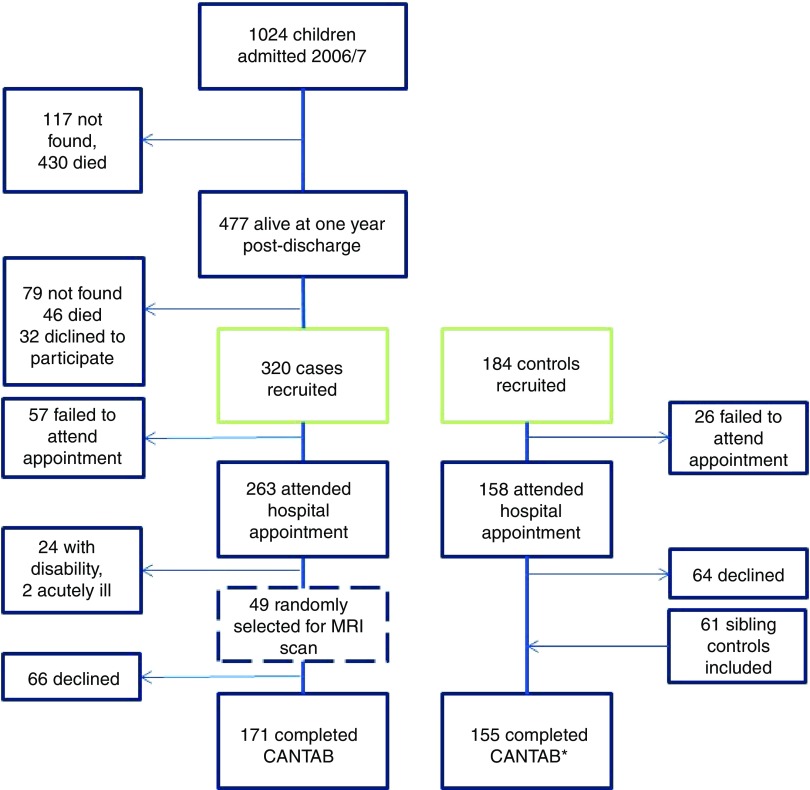
(colour online) Recruitment flow diagram for brain structure and cognitive function outcomes among Malawian children. *Of the 155 CANTAB controls, ninety-four were community children and sixty-one were siblings (CANTAB, Cambridge Neuropsychological Testing Automated Battery)